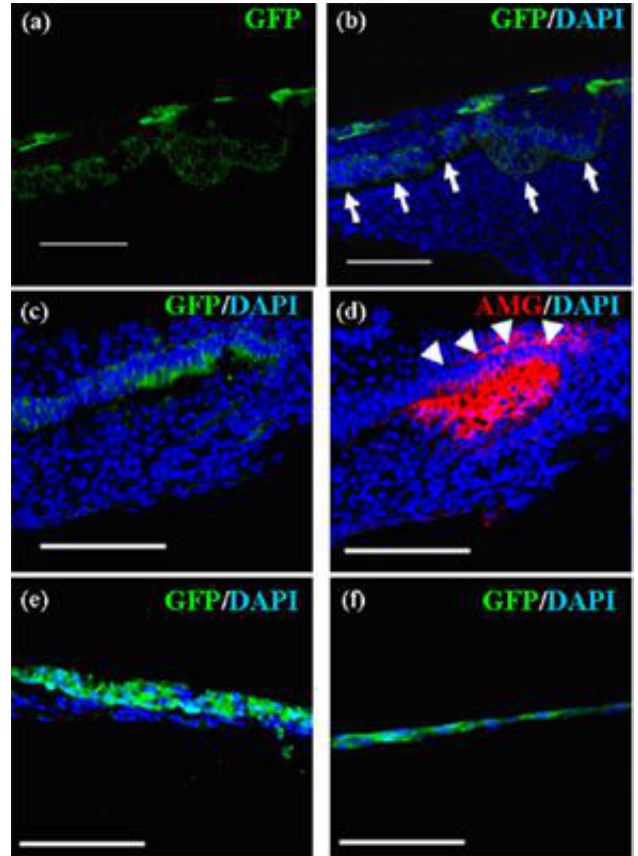
Figure 5. Localization of emtg-2 cells in constructed teeth. ( a (cid:177) d ) Germs were prepared with GFP-labeled emtg-2 cells and EC (1:0.5) and MT, and cultured on inserts for seven days. Constructed teeth were subjected to immunohistochemistry. ( a , b ) GFP-labeled emtg-2 cells (green) were localized in the dental epithelium and inner enamel epithelium (arrows). ( c , d ) GFP-labeled emtg-2 cells (green) in the inner enamel epithelium expressed amelogenin protein (red) (arrowheads). ( c ) and ( d ) are serial samples. ( e , f ) Germs reconstructed with emtg-2 cells and MT were cultured for three and seven days,